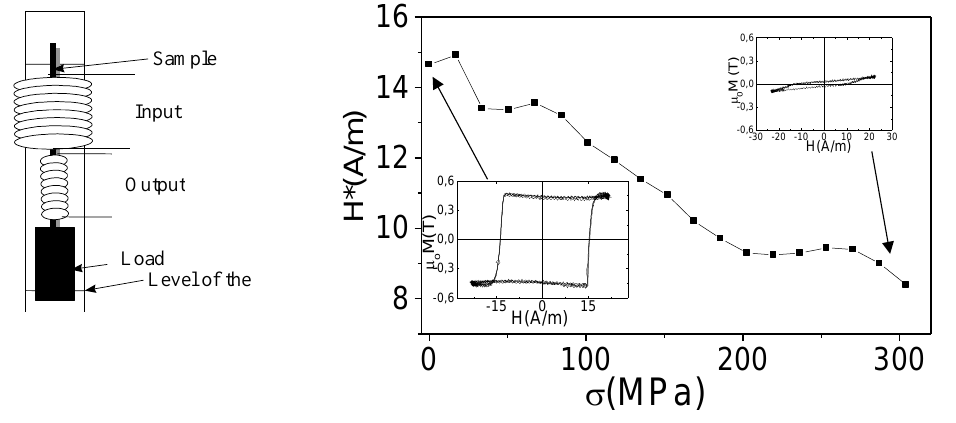
Figure 14. Schematic representation of the magnetoelastic sensor based on stress dependence of the switching field